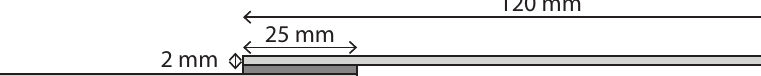
Figure 5. Single lap joints